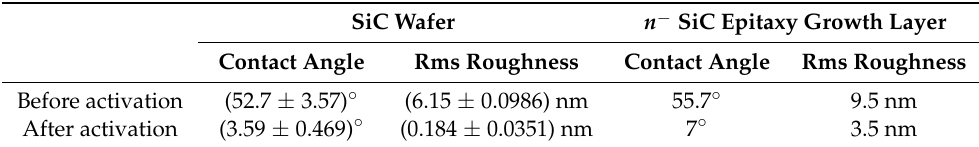
Table 1. Contact angle and RMS roughness before and after activation.